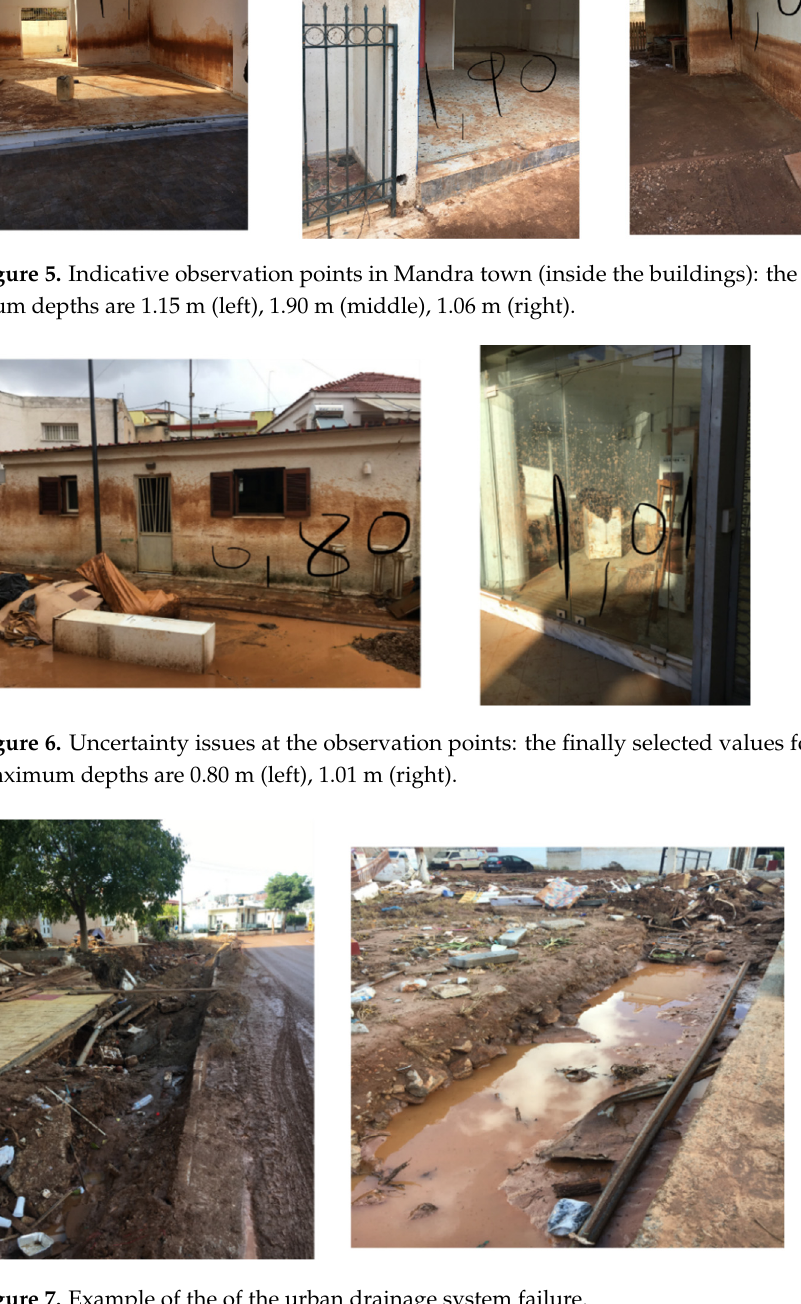
Figure 7. Example of the of the urban drainage system failure.